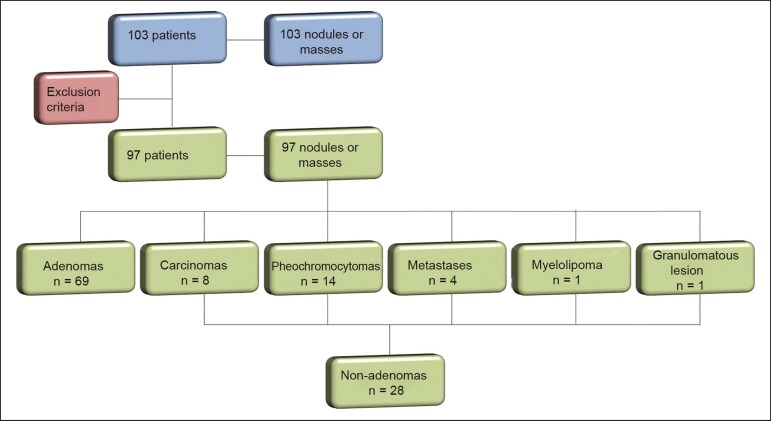
Study flow diagram.